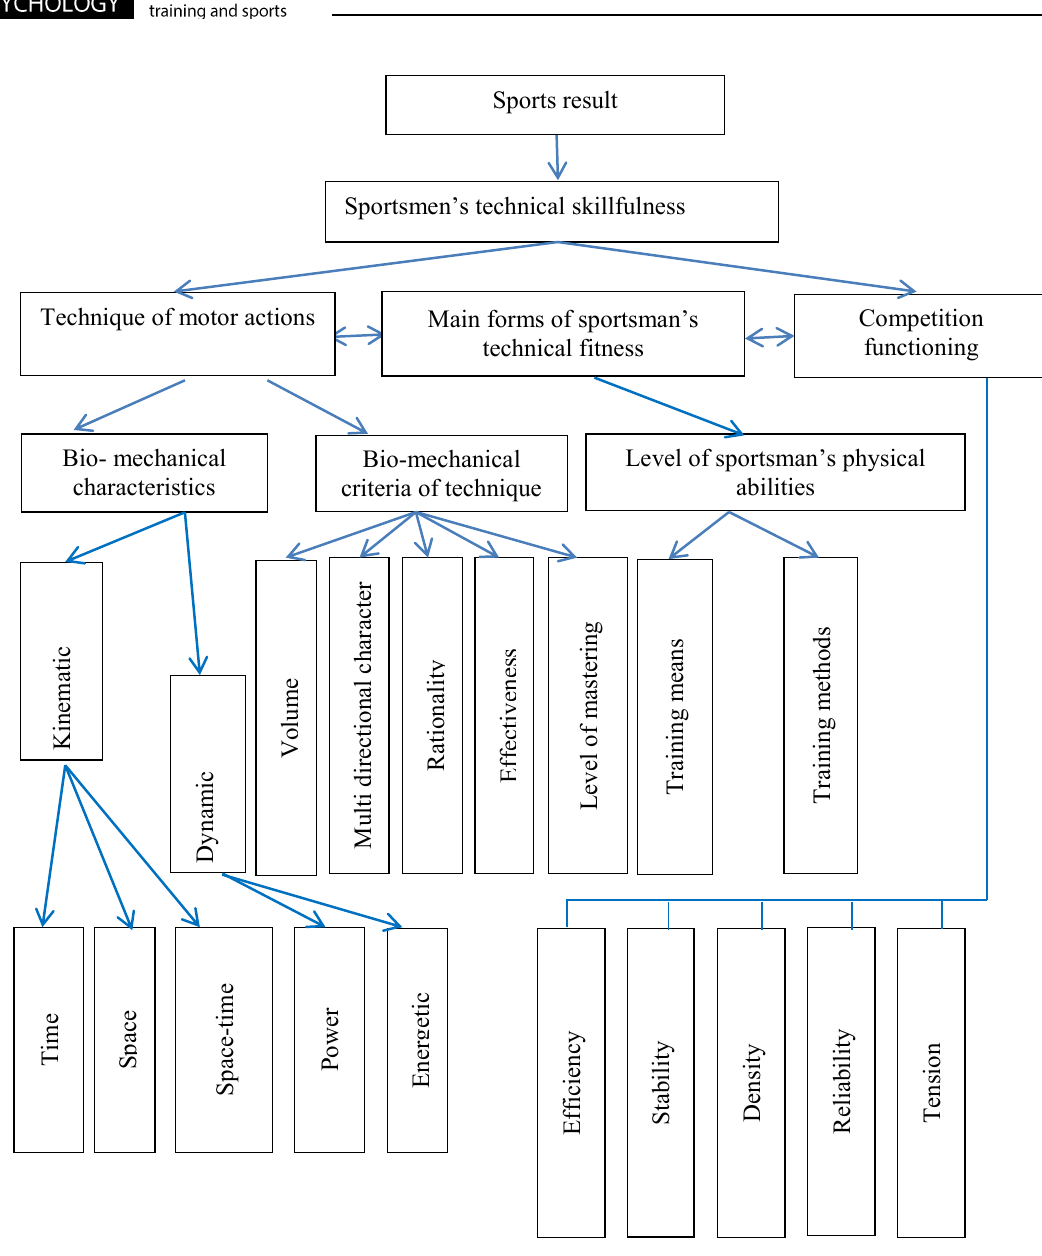
Fig.1. Main structural components of sportsmen’s technical